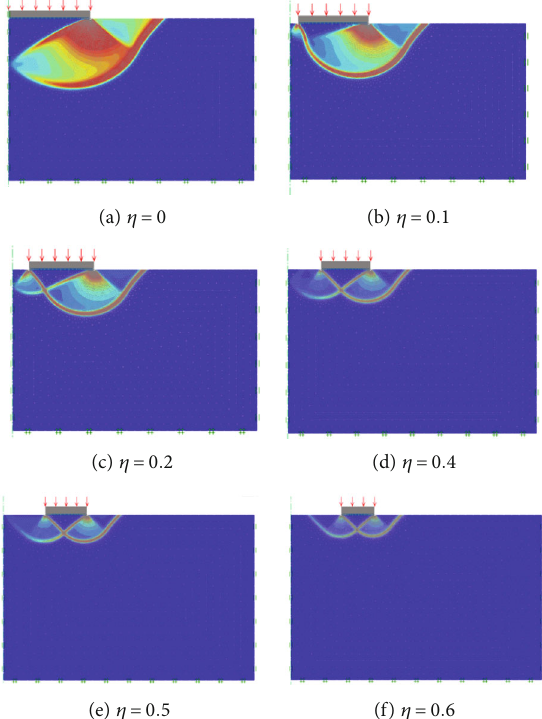
Figure 3: Failure patterns of the ring foundation with di ff erent inside-to-outside radius